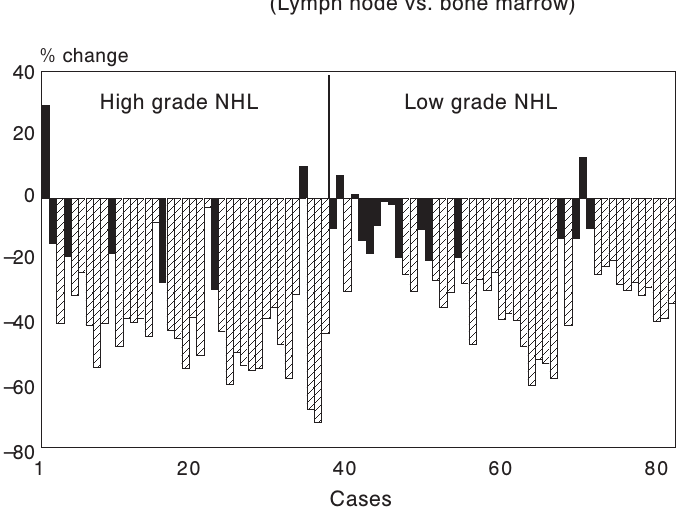
Fig. 1. Differences between mean nuclear area (MNA) measurements from lymph nodes and their corresponding bone marrow trephines in non Hodgkin’s lymphoma. The “% change” denotes the value of the MNA in the bone marrow expressed as a percentage of the MNA in the lymph node. Zero representing identical values in both bone marrow and lymph node; negative values denoting smaller nuclei in bone marrow; and positive values denoting the converse. The cases in black reflect differences which might be explainable on the basis of sampling differences alone (see control studies – Table 3). Table 5 Morphological appearances of nuclei in bone marrow lymphoid infiltrates. The figures denote